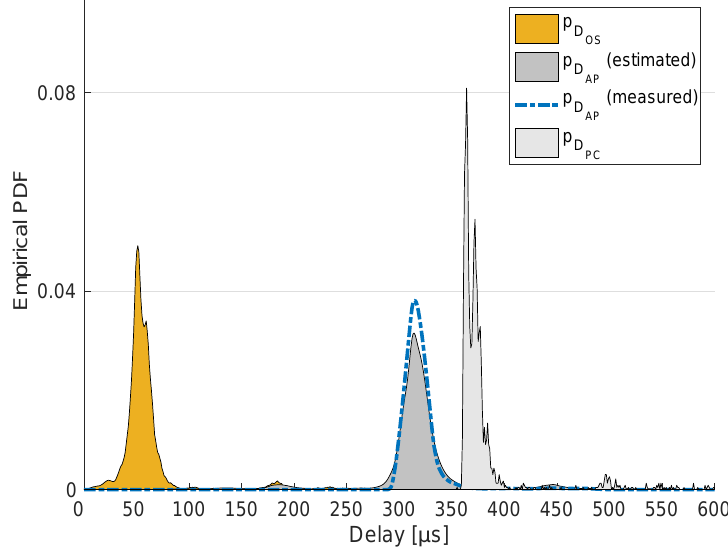
Figure 8. Result of the estimation for the 3Com AP, and a comparison between the measured and estimated AP